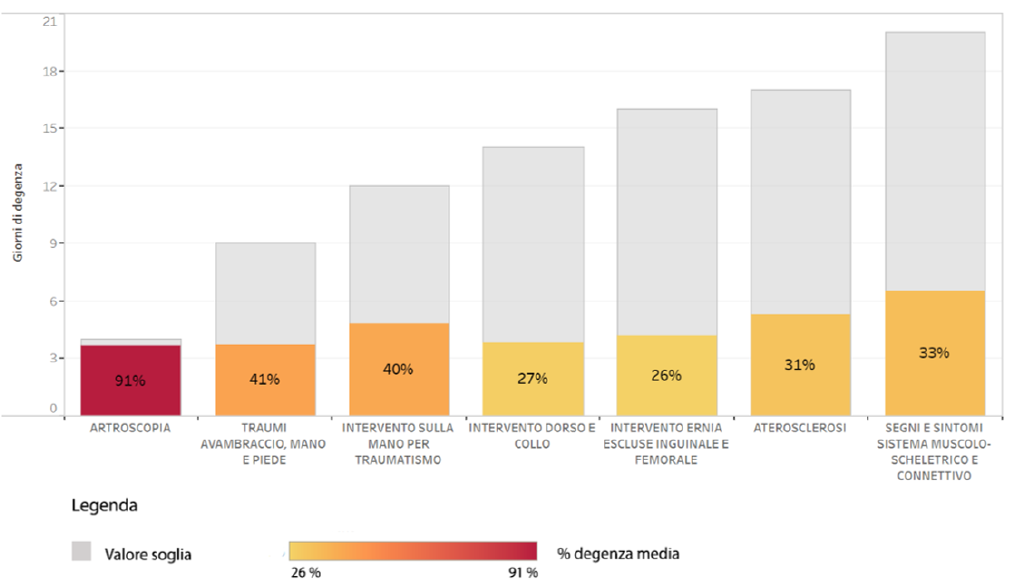
Figure 4. Bar chart with average number of days ( y -axis) by hospital of inpatient stays for some diseases and surgical operations expressed both in absolute value (height of bars in gray with relative legend “valore soglia”, which stands for threshold value) and in percentage (“% degenza media” represented in percentage, and colored gradient from red, higher percentage, to yellow, lower percentage) with respect to the threshold value. Examples of depicted surgical operations are arthroscopy, and back, hernia, and hand surgery.